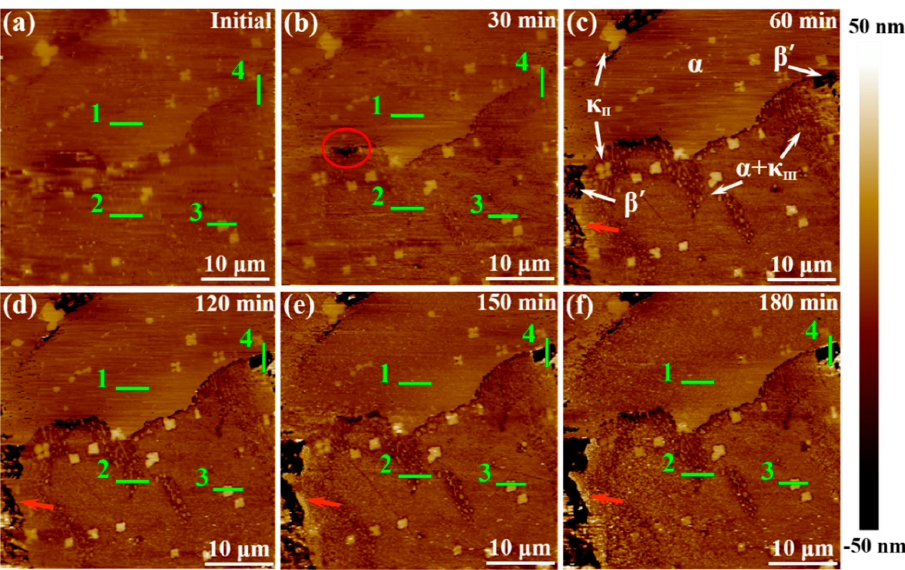
Figure 9. In-situ topography images of NAB specimen surface after exposure to 3.5 wt % NaCl solution for different times: ( a ) initial; ( b ) 30 min; ( c ) 60 min; ( d ) 120 min; ( e ) 150 min; ( f ) 180 min.